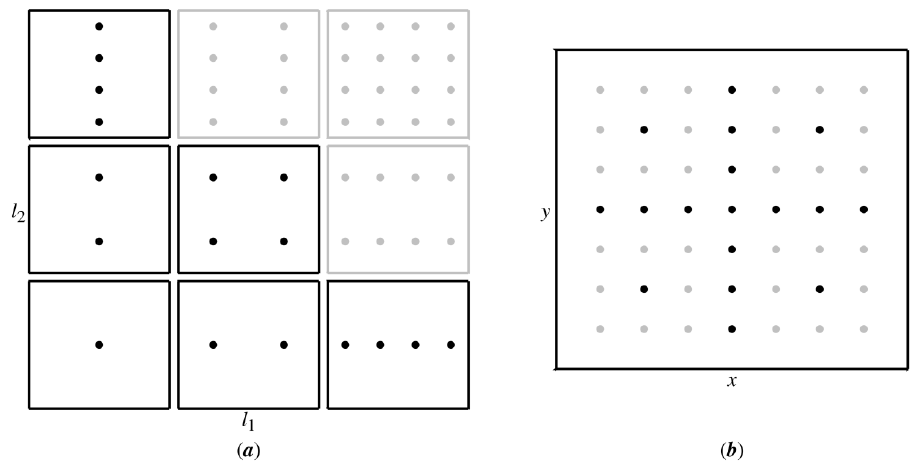
Figure 3. Sparse grid of the third level: black dots—sparse grid; black and grey dots—full grid: ( a ) sets of points corresponding to basis functions of the same level; ( b ) combining all points into one grid.